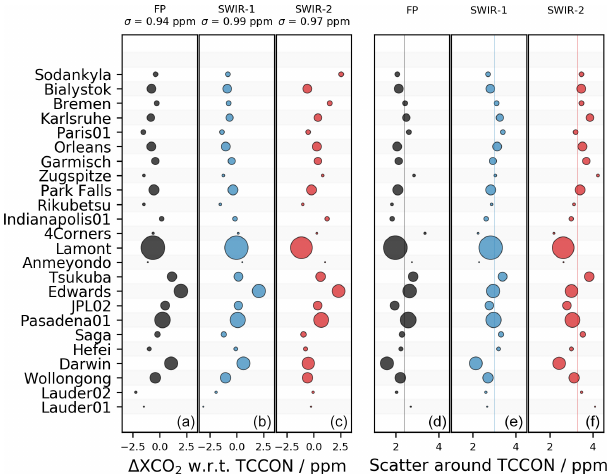
Figure 5. Comparison of retrieval performances at individual TC- CON stations sorted north to south. Marker size indicates number of colocated soundings at each station. (a, b, c) Station-by-station mean differences between TCCON and the native (black), SWIR-1 (blue) and SWIR-2 (red) retrievals from GOSAT. The standard de- viation of mean differences among the stations, σ , amounts to 0.94 (native), 0.99 (SWIR-1) and 0.97ppm (SWIR-2). (d, e, f) Scatter around TCCON per station for the native, SWIR-1 and SWIR-2 re- trievals. Vertical lines mark the average standard deviations (native: 2.43; SWIR-1: 3.00; SWIR-2: